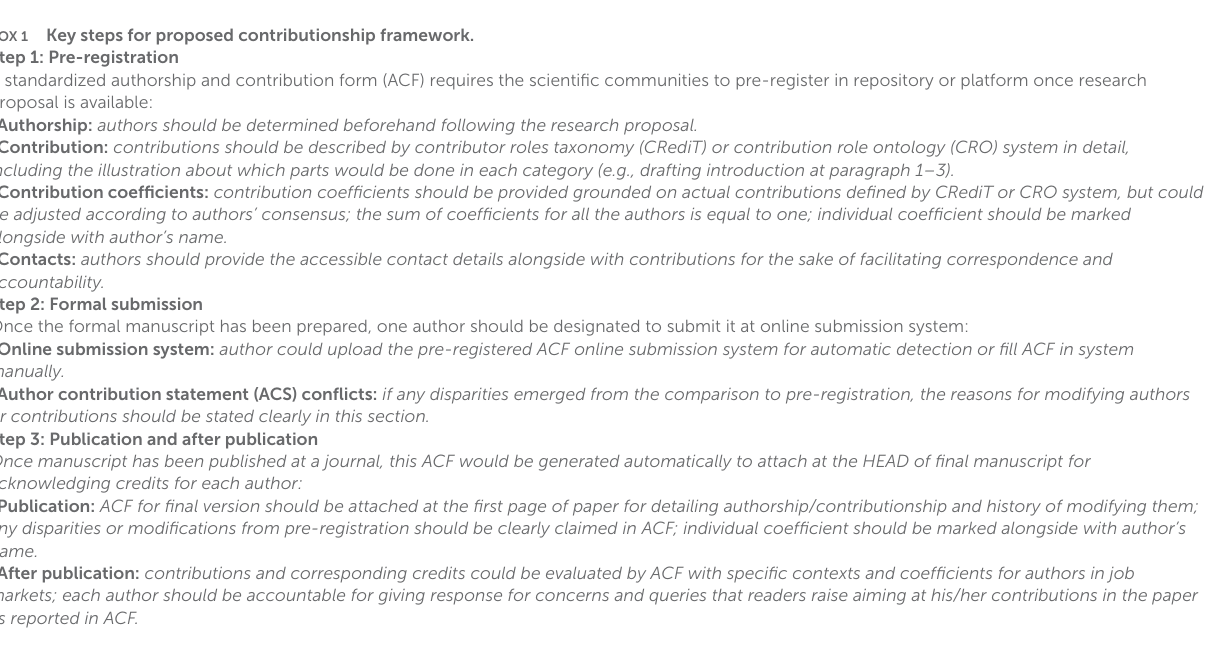
BOX1 Key steps for proposed contributionship framework. Step 1: Pre-registration